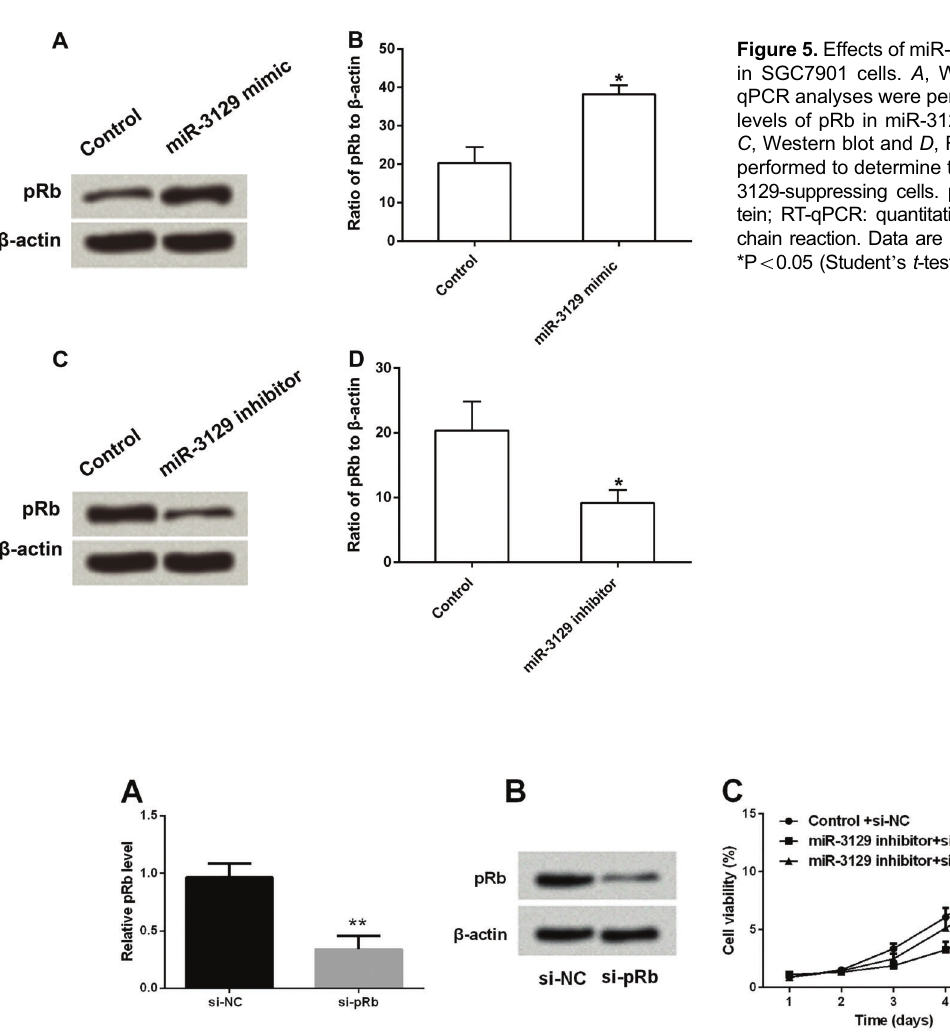
Figure 6. Effects of si-pRb transfection on pRb expression and cell viability of SGC7901 cells transfected with si-pRb and si-NC for 48 h. A , RT-qPCR and B , western blot analysis was performed to assess the expression levels of pRb. SGC7901 cells were co-transfected with miR-3129 inhibitor and si-NC, or co-transfected with miR-3129 inhibitor and si-pRb. C , cell viability was measured by MTT assay. RT-qPCR: quantitative real time polymerase chain reaction; pRb: retinoblastoma protein; si-pRb: siRNA targeted pRb. Data are reported as means ± SD. **P o 0.01, ***P o 0.001, # P o 0.05 (ANOVA followed by Tukey post hoc